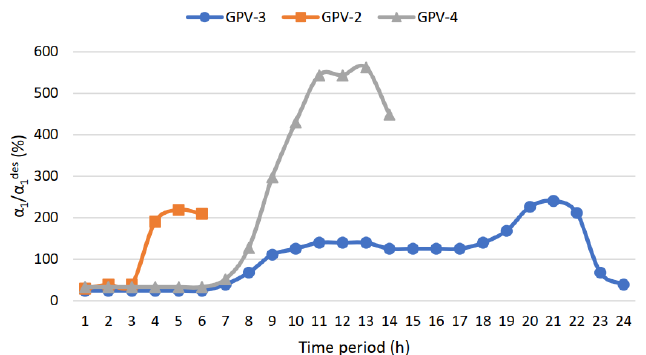
Figure 18. Angle α 1 variation with respect to design point for each time period and GPV.